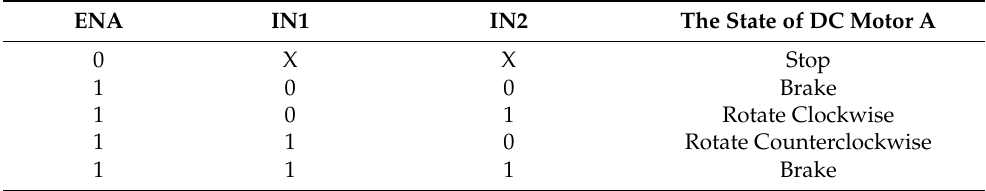
Table 1. Driver chip